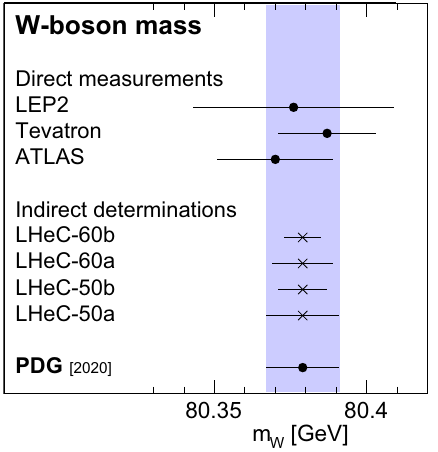
Fig. 4 Determination of the W -boson mass from a combined m W +PDF fit, assuming fixed values for all other EW parameters. Dif- ferentLHeCscenarioswithbeamenergiesof E e = 60GeVand50GeV as described in the text are considered and compared with existing mea- surements [63–65] and with the world average value (PDG2020) [41]